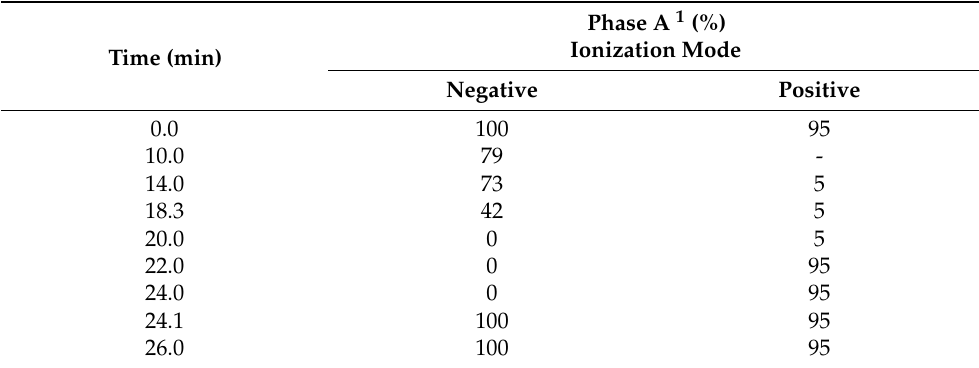
Table 2. Mobile phase gradient program.